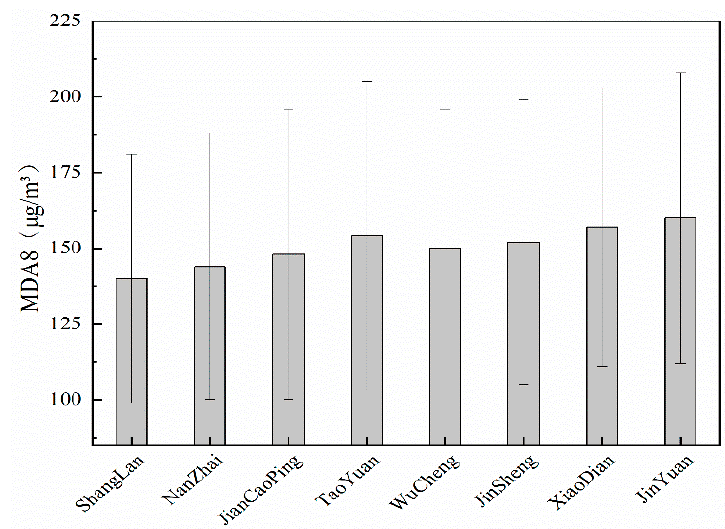
Figure 5. Average MDA8 at each site in Taiyuan, from April to August 2018.